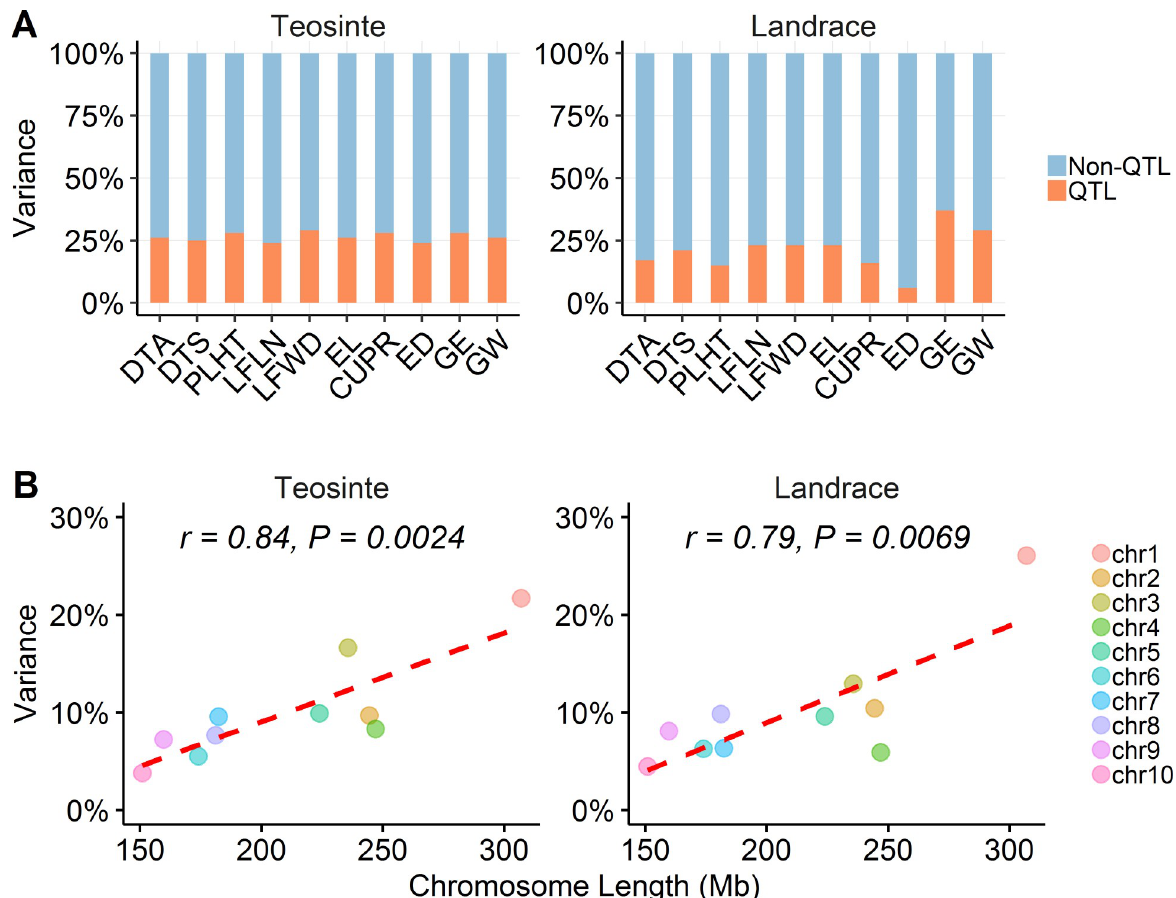
Fig 6. Missing heritability. (A) The percentage of variance explained by QTL and non-QTL, respectively. Most heritable variation is "missing" in both teosinte and maize landrace. (B) The relationship between chromosome length and the proportion of variance. The correlation coefficient r and corresponding P value is indicated. The proportion of variance explained by chromosomes is positively correlated with chromosome length in both teosinte and maize